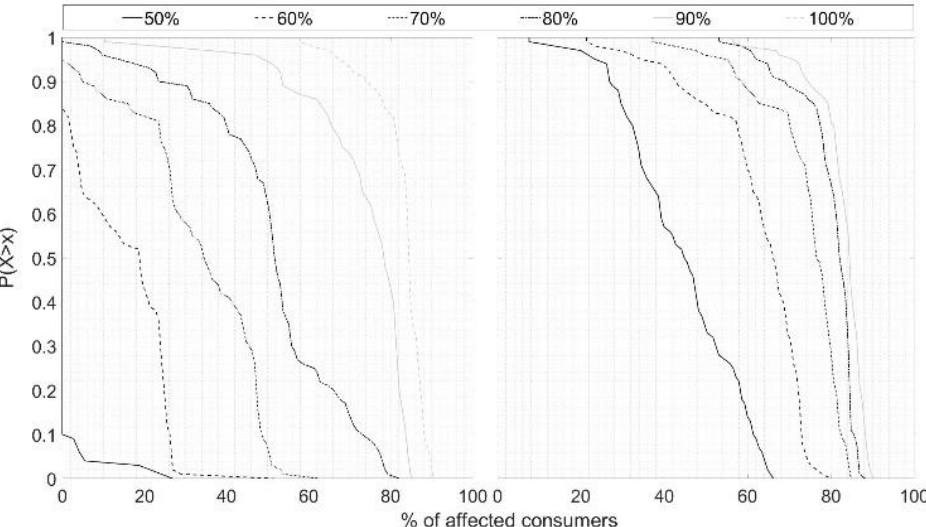
Figure 5. Feeder 4 CDFs results: voltage issues.